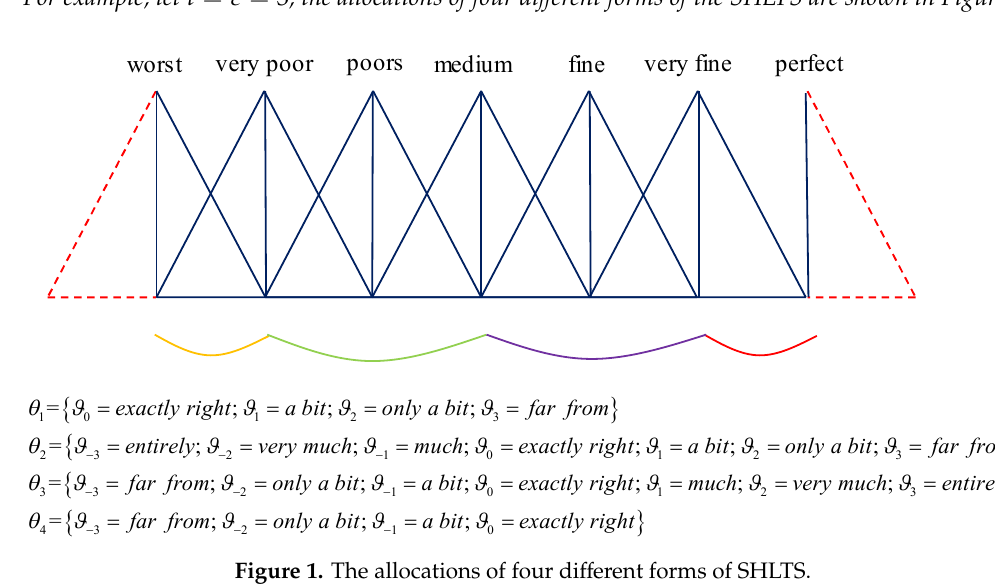
Figure 1. The allocations of four different forms of SHLTS.